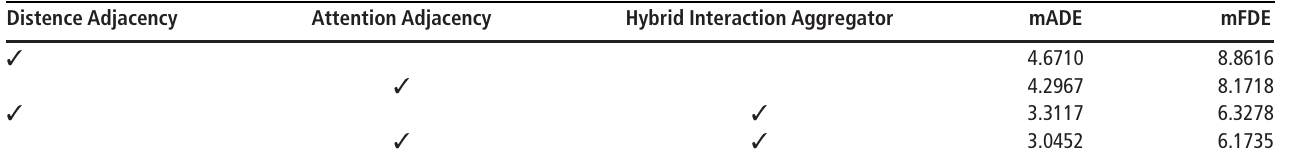
Table 2 Ablation on social-lane aggregator Distence